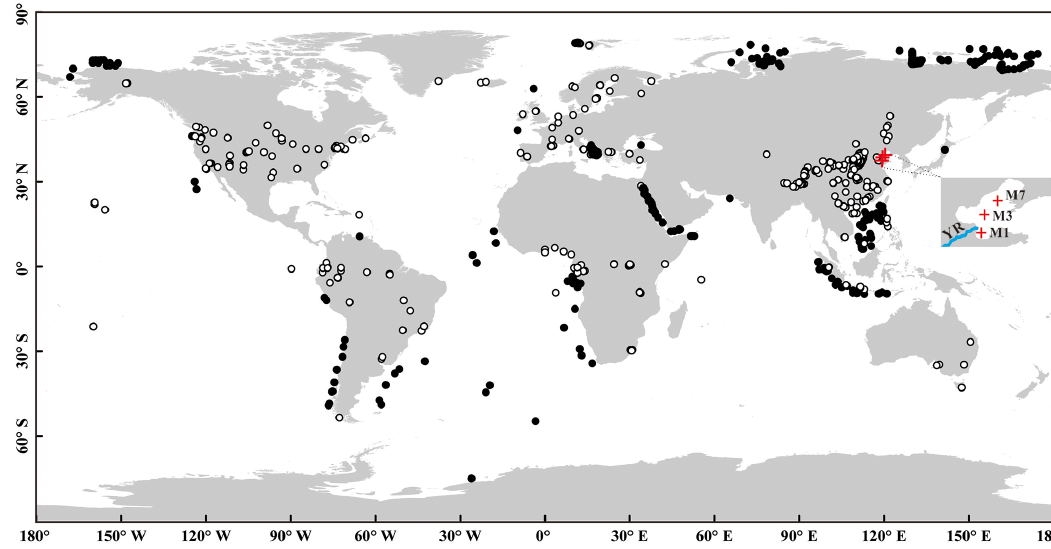
Figure 2. Location of the samples used in this study. White circles and black circles indicate the soils and marine sediments, respectively. Red crosses denote three sediment cores (M1, M3 and M7) in the Bohai Sea. YR is the Yellow River.